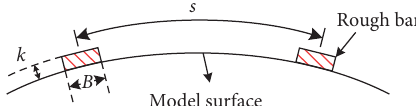
Figure 7: Diagram of surface roughness